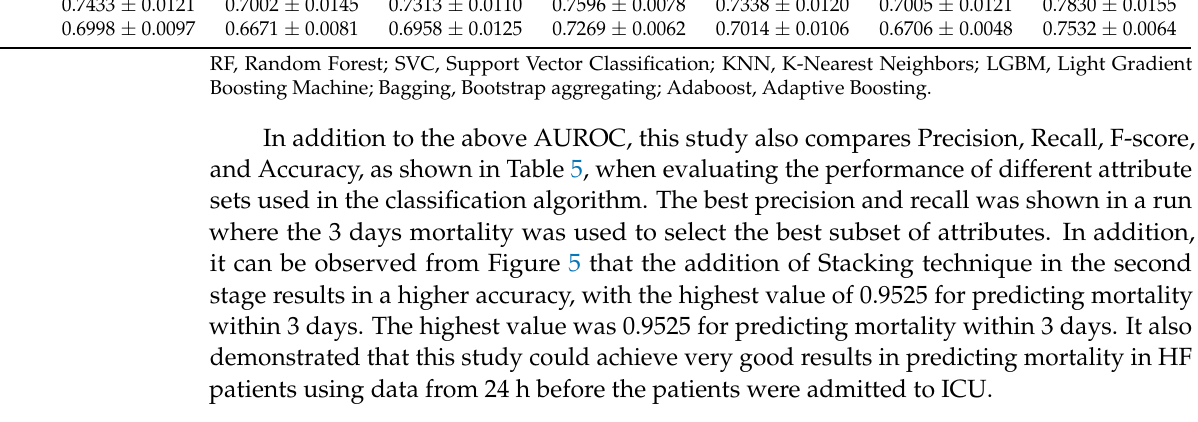
Table 5. Diagnostic Precision, Sensitivity, F-Score, and Accuracy of different